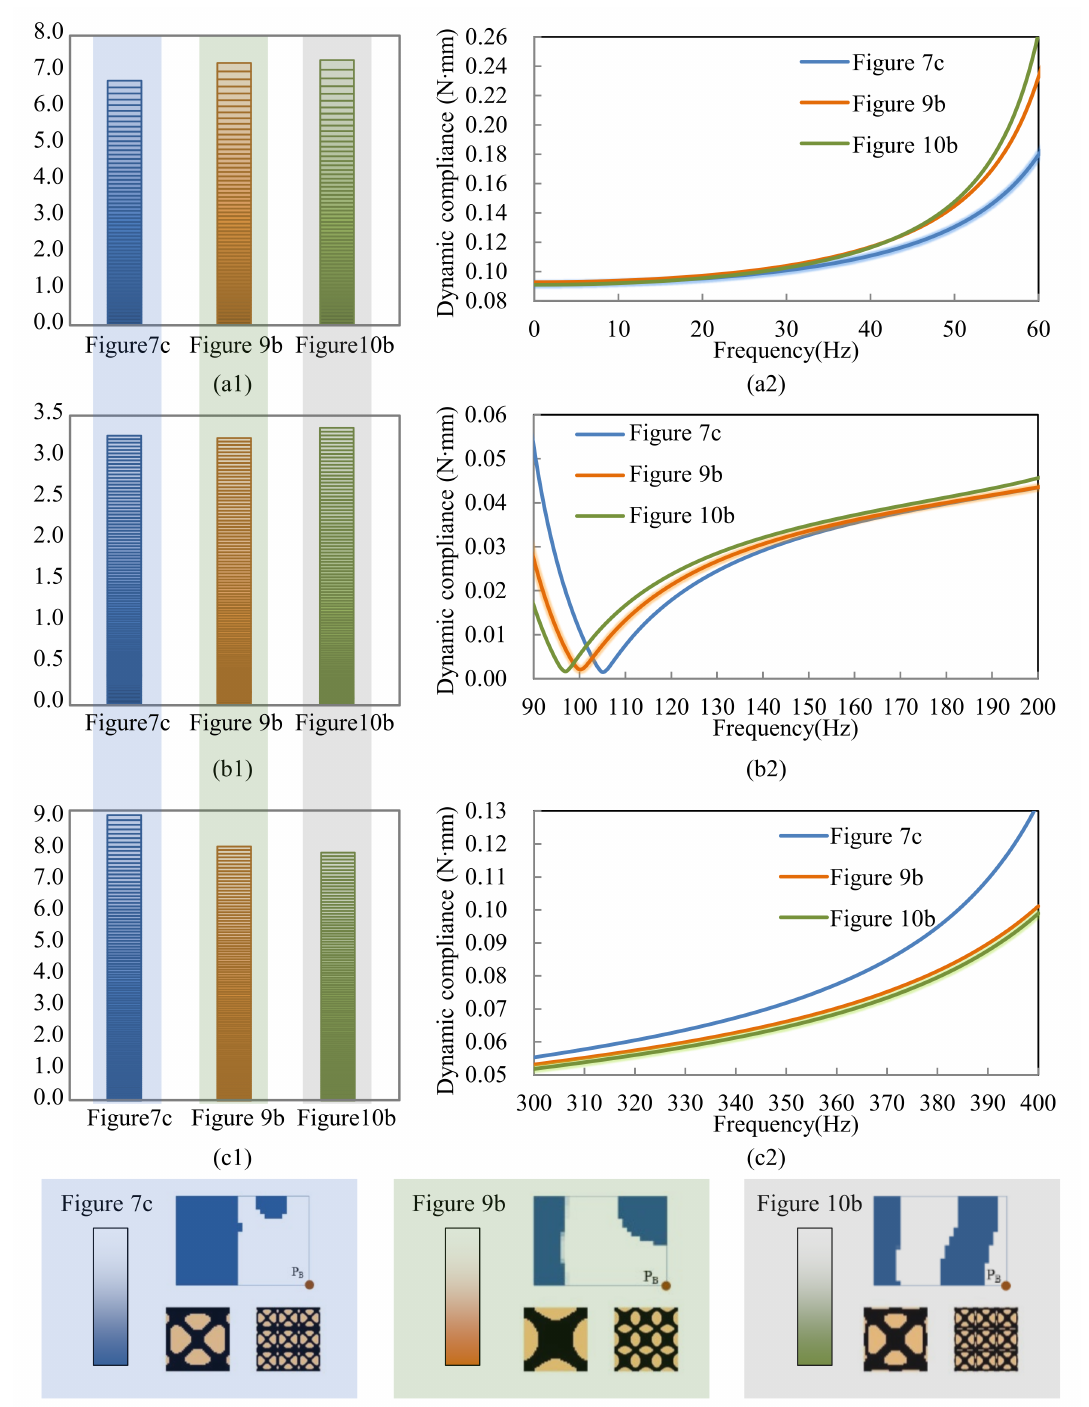
Figure 12. Dynamic compliance of the results is shown in Figures 7c, 9b and 10b when the excitation point is at P B . ( a1 ) the sum of dynamic compliance 0–60 Hz, ( a2 ) dynamic compliance in the frequency range 0–60 Hz. ( b1 ) the sum of dynamic compliance 90–200 Hz, ( b2 ) dynamic compliance in the frequency range 90–200 Hz. ( c1 ) the sum of dynamic compliance 300–400 Hz, ( c2 ) dynamic compliance in the frequency range 300–400